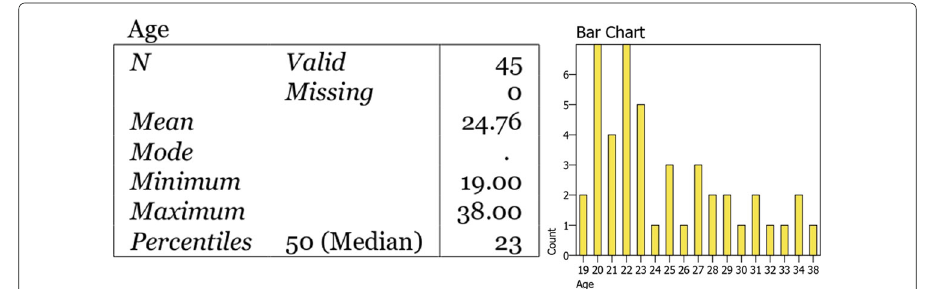
Fig. 8 Distribution of age in the sampled students from evening groups